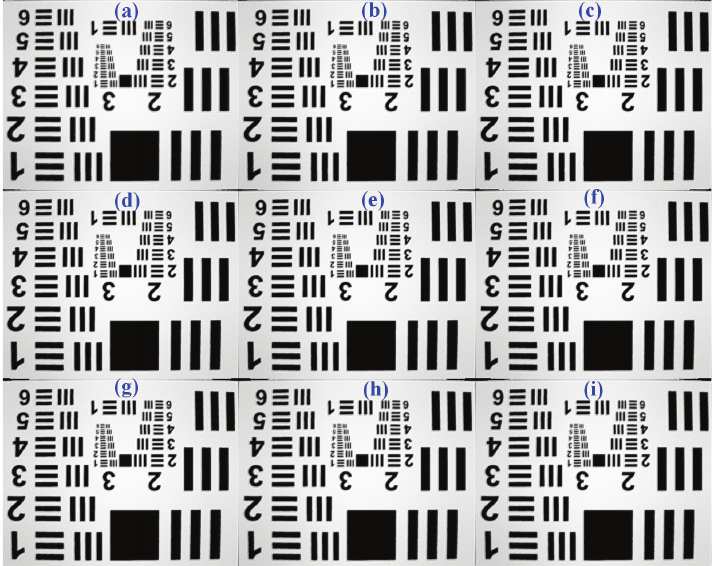
Figure 11. Imaging results of wavefront-coded optical endoscope in different objective distances. ( i ) 4.5